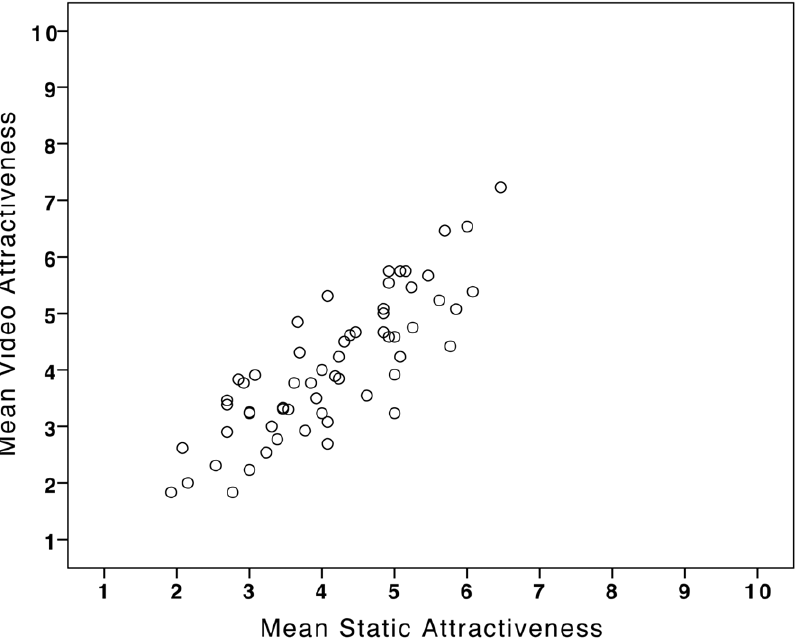
Figure 1. The association between attractiveness rated from videos and static images of faces (N=60). doi:10.1371/journal.pone.0026653.g001 PLoS ONE |